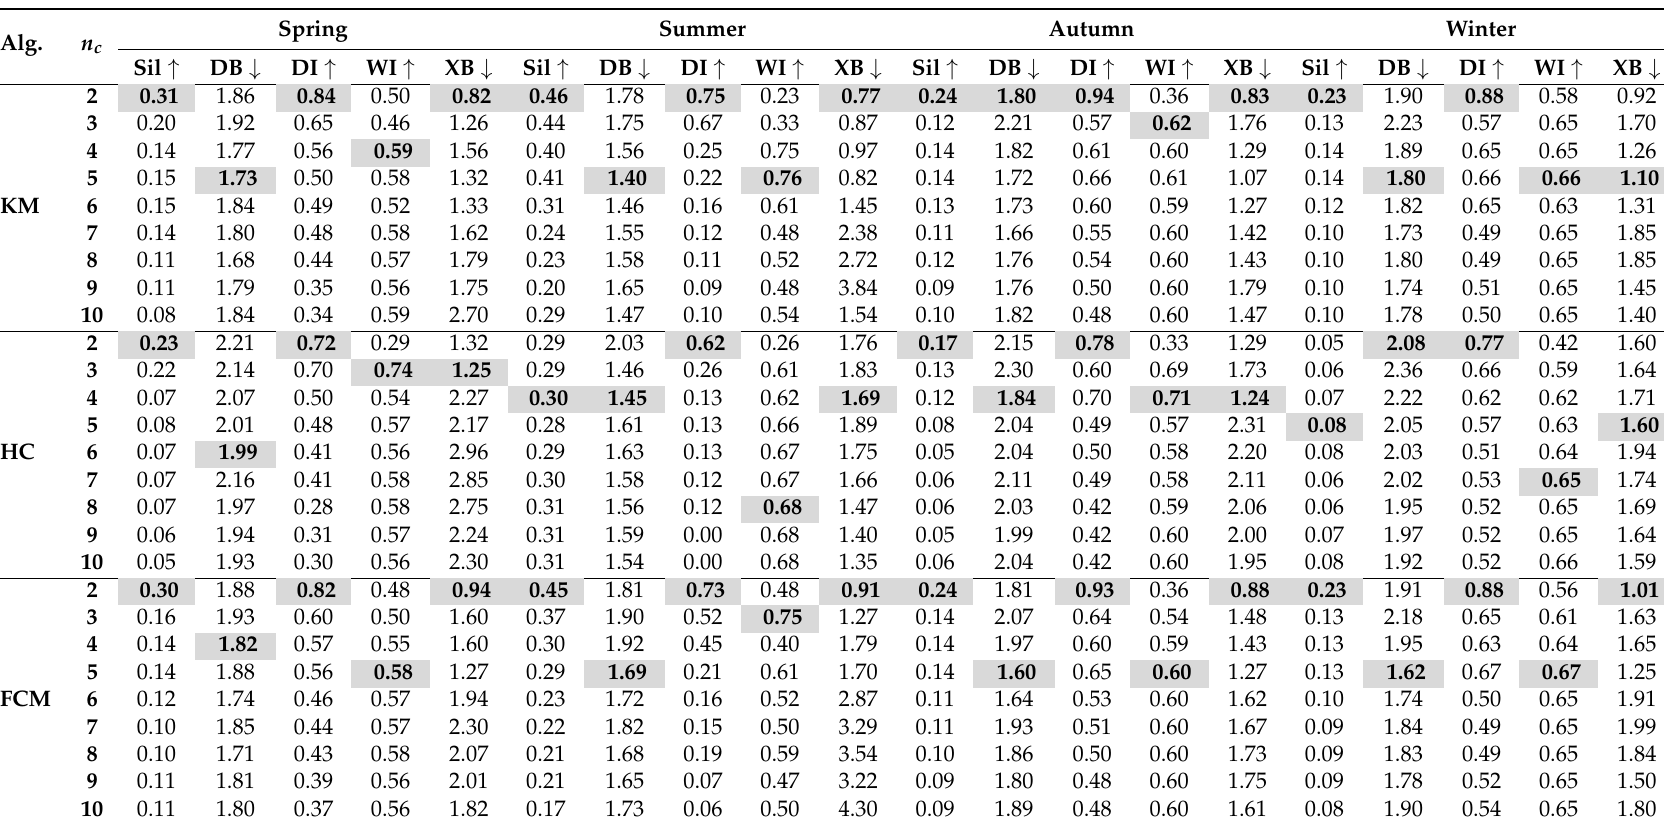
Table A1. Seasons’ CVIs, where the best values of the indices are highlighted in grey color, for a certain number of clusters n c for each algorithm.